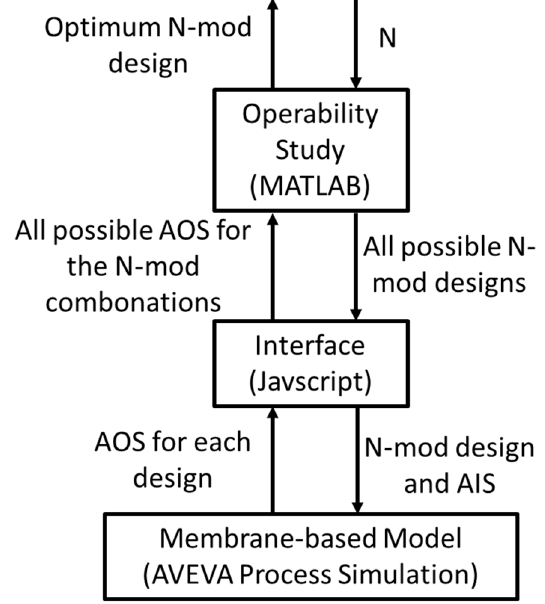
Figure 7. Computational framework developed for determining the optimum N-mod design.